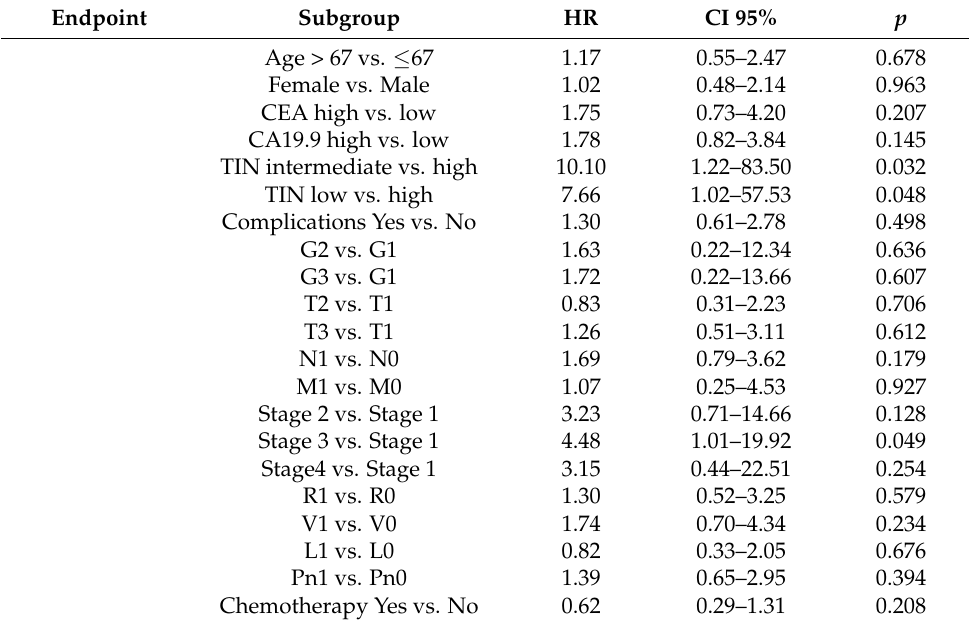
Table 2. Results of the univariate